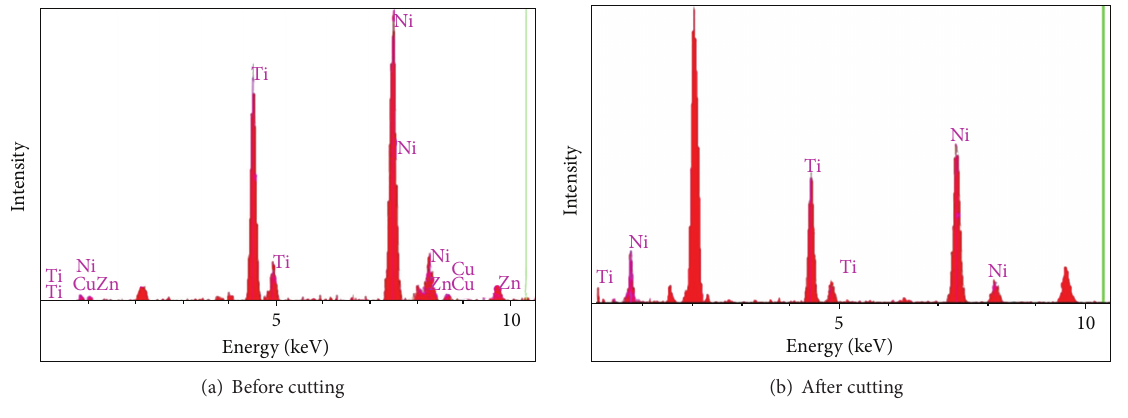
Figure 4: EDXA analysis of